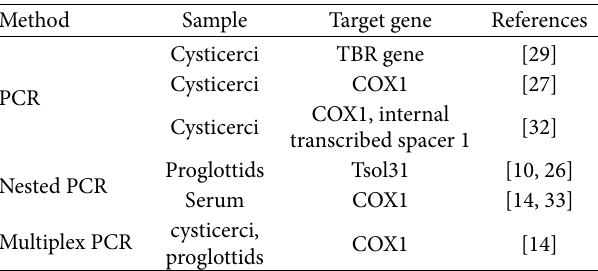
Table 1: PCR based techniques for Taenia solium